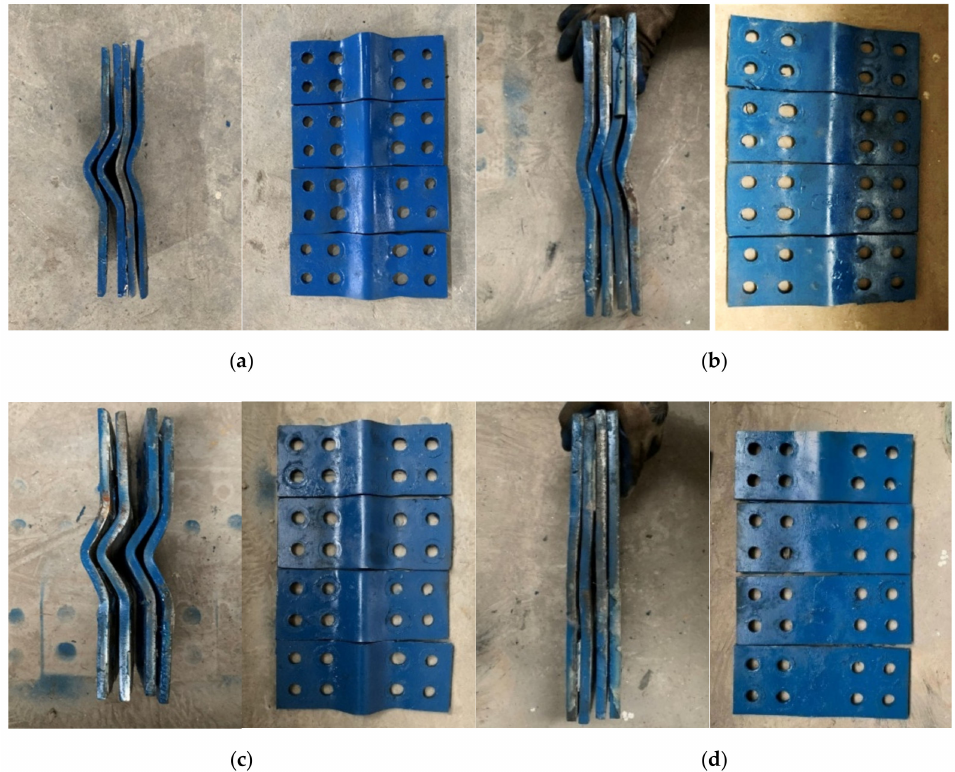
Figure 10. Deformation of connecting steel plates: ( a ) J1-235-10; ( b ) J2-160-10; ( c ) J3-345-10; ( d )